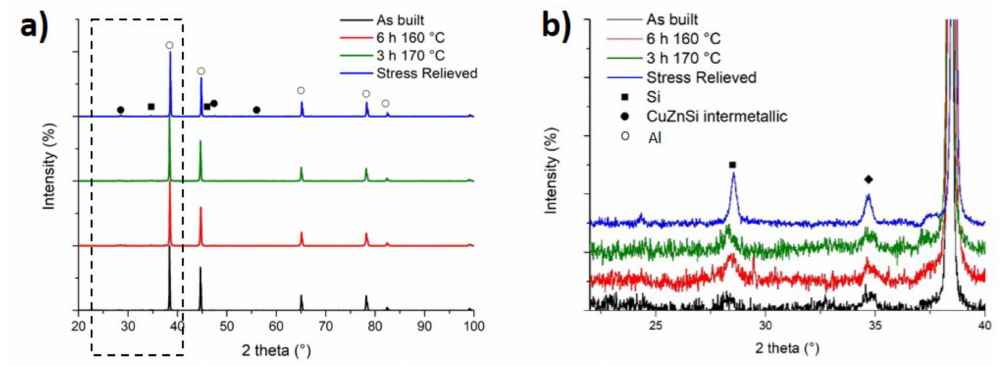
Figure 8. ( a ) XRD patterns of 50% 7075 alloys in the as built state and after different heat treatments and ( b ) magnification in the range of 22–42 ◦ .